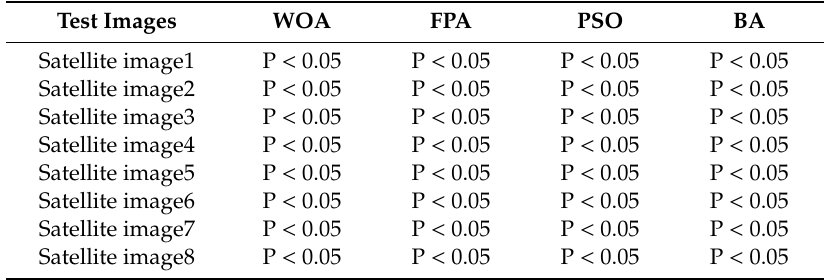
Table 4. The calculated p-values from the Wilcoxon test for the 3DPCNN-HSOA versus other optimizers. Test Images